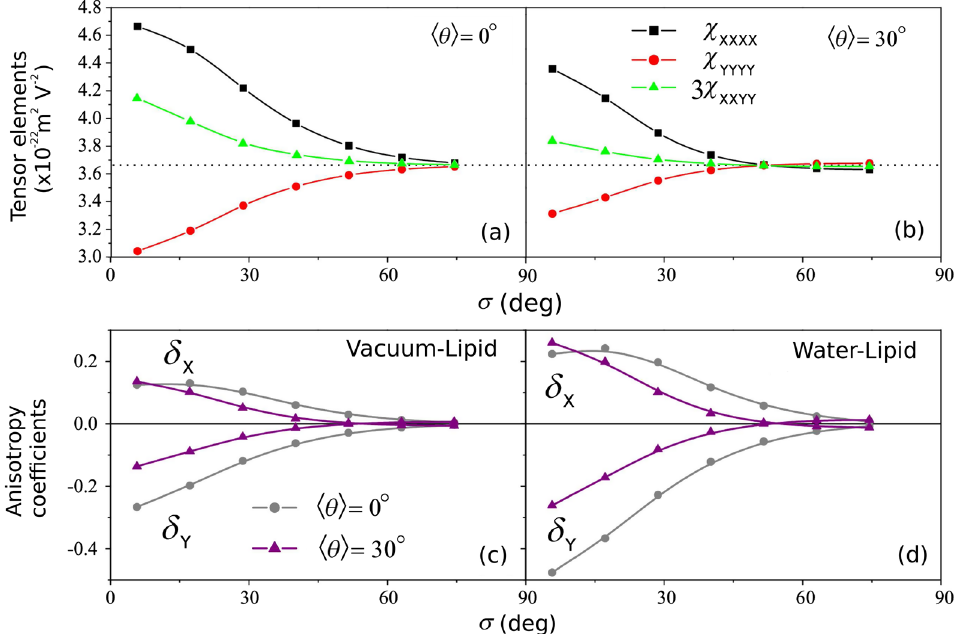
FIG. 2. Calculated nonlinear optical properties of multilamellar lipid structures and interfaces. The (cid:3) ð 3 Þ ML tensor elements of (a) liquid-phase ðh (cid:7) i ¼ 0 (cid:4) Þ and (b) gel-phase ðh (cid:7) i ¼ 30 (cid:4) Þ lipids as a function of disorder (cid:8) . Higher ordering results in greater (cid:3) ð 3 Þ ML anisotropy for the liquid phase; in the gel phase, optical isotropy is achieved at lower disorder. The elements are also shown to approach the same value of h (cid:3) ð 3 Þ ML i (dotted line) as the system approaches isotropy. (c),(d) The anisotropy coefficients (cid:10) characterize the magnitude of the anisotropy-induced P-THG signal oscillation. Generally, for a pair of coefficients, (cid:10) < 0 , and their magnitude is larger for liquid-phase interfaces (gray curves) relative to the gel-phase interfaces (purple curves). For (cid:10) Y ¼ (cid:10) ¼ 0 ; thus, the gel-phase curves [corresponding to the tensor elements in (b)] cross an interface between two isotropic media, (cid:10) X Y at (cid:8) (cid:5) 45 (cid:4) , and the liquid-phase curves [corresponding to (a)] cross at (cid:8) (cid:5) 75 (cid:4) . Comparing the (c) vacuum-lipid and (d) water-lipid interfaces shows that (cid:3) ð 3 Þ matching of the second, isotropic material can potentially be used to enhance the P-THG